Question: Reading the figure, is the described quantity rising or falling?
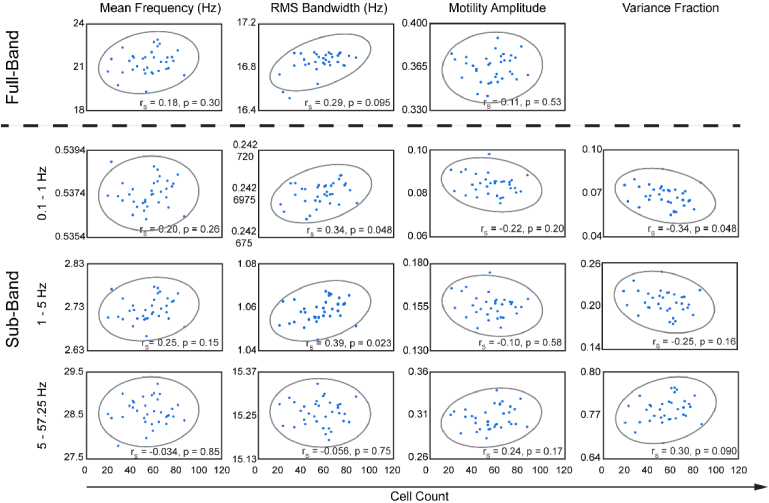
Answer: increasing